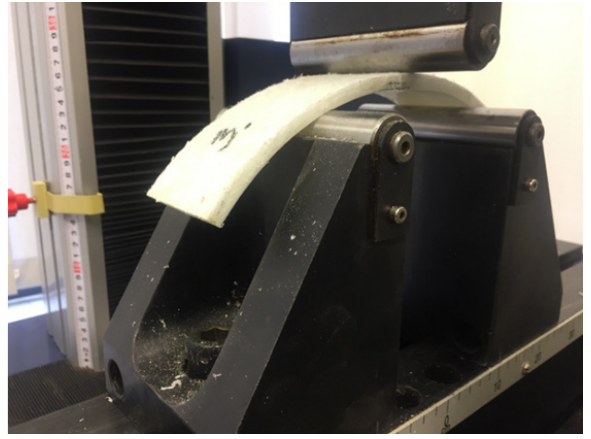
Figure 9: Laboratory test of a liner – diameter 350 mm.